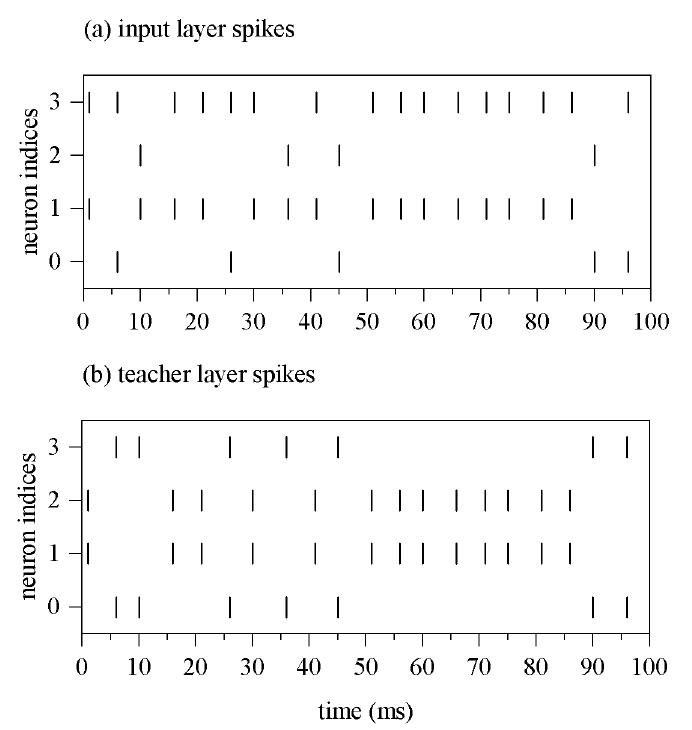
Figure 4. The training data of logical module AND in the first 100 ms. ( a ) Iput layer spikes: neuron indices 0 ∼ 3 correspond to Neuron 0 and Neuron 1 of the first input logic variable and Neuron 0 and Neuron 1 of the second input logic variable in Figure 2. ( b ) Teacher layer spikes: neuron indices 0 ∼ 3 correspond to the positive teacher Neuron e 0 , e 1 and the negative teacher Neuron i 0 , i 1 in Figure 2.